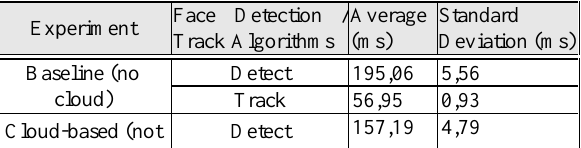
Table 4. CPU Comparative load in exhaustive case.